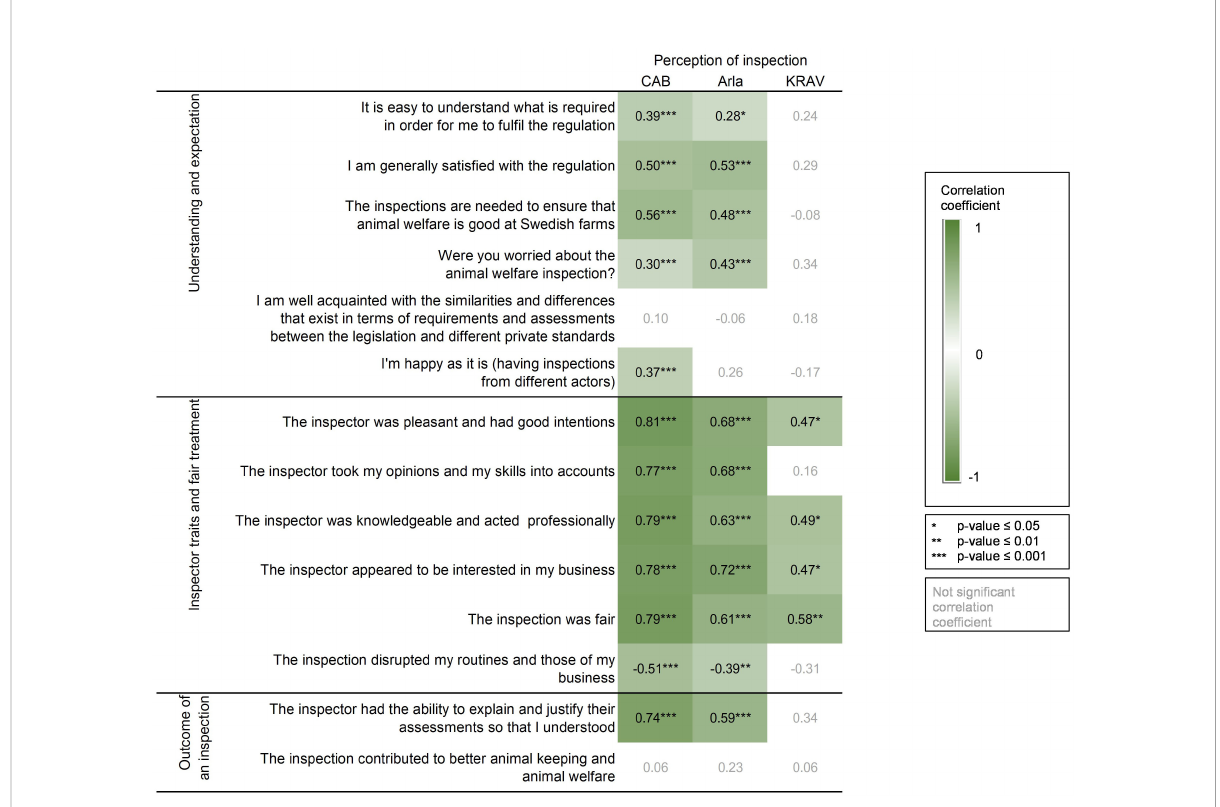
FIGURE 3 Correlation between graded questions (to the left) and farmers ’ perception of each type of inspection (CAB (n = 109-121, Arla (n = 49-55) and KRAV (n = 25)). The correlation coef fi cient r is shown in each cell and p -value intervals are indicated with stars. Non-signi fi cant coef fi cients have white background and gray text, while signi fi cant values are colored, with stronger color indicating a stronger correlation. Responses to all questions ranged from 1 = disagree to 5 = agree, except the question of whether the respondent was worried about the inspection (range 1 = yes to 5 =